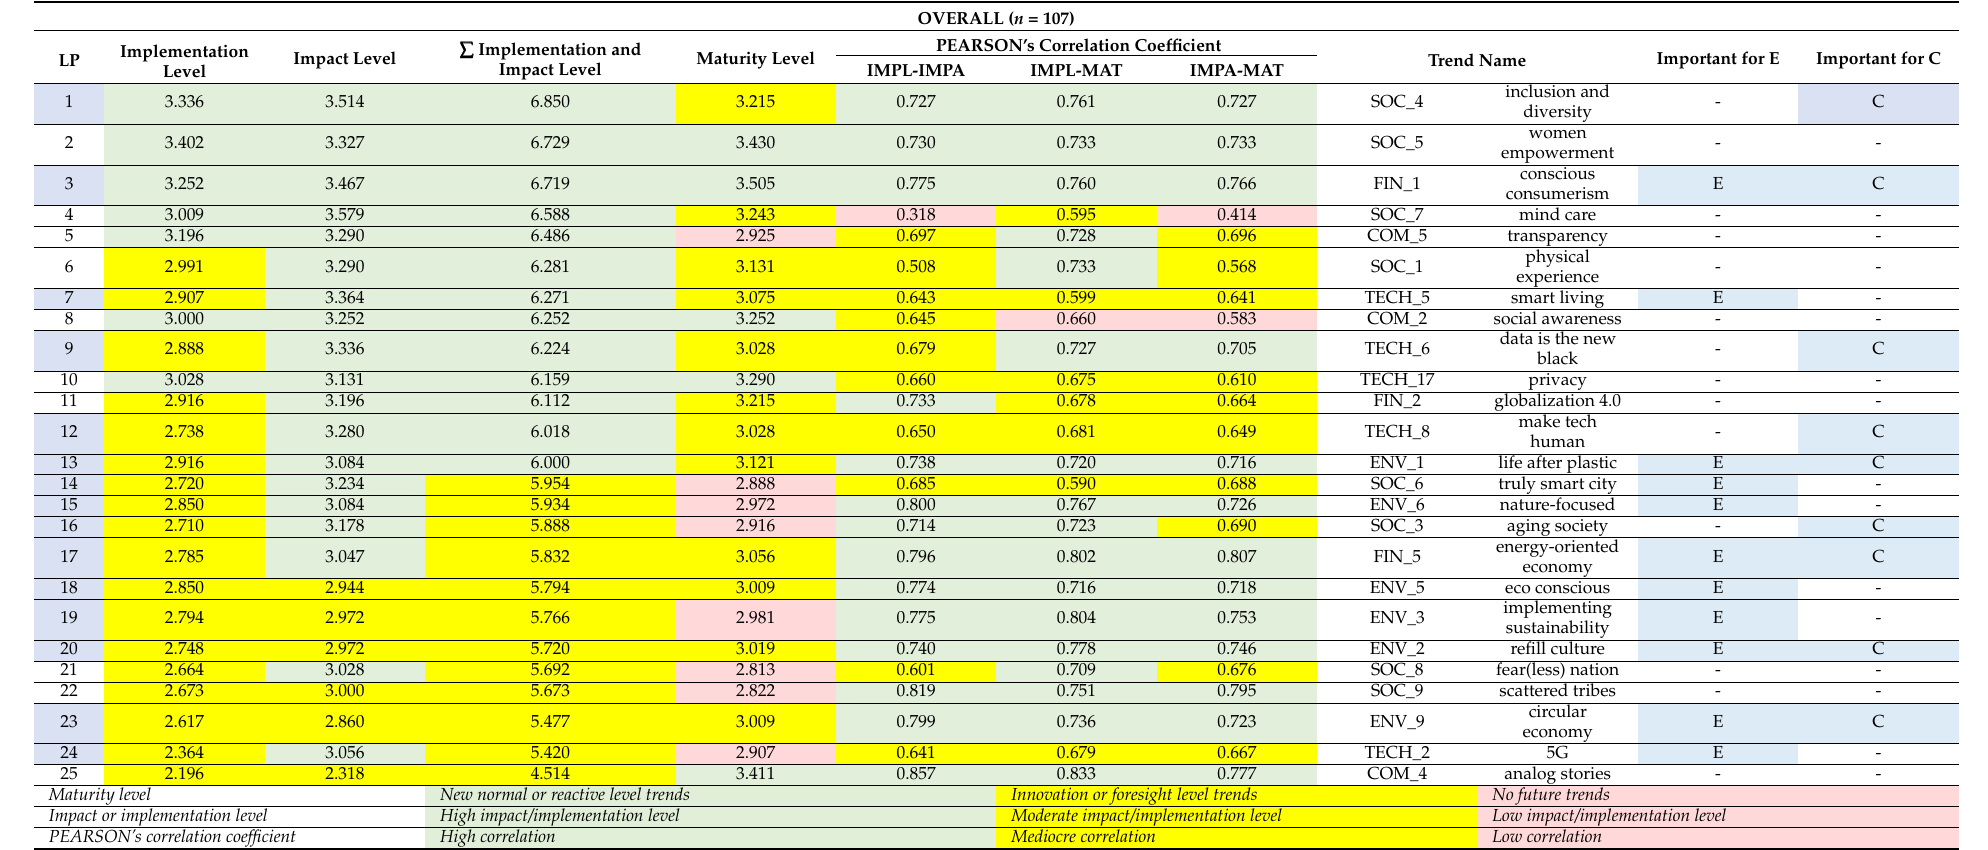
Table 4. Top 25 S.T.F.E.C. SMART management trends—overall